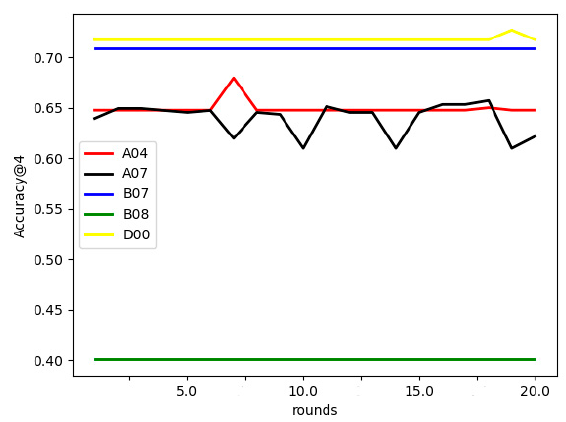
Figure 4. Effect of communication rounds on FL-AHNEAP.